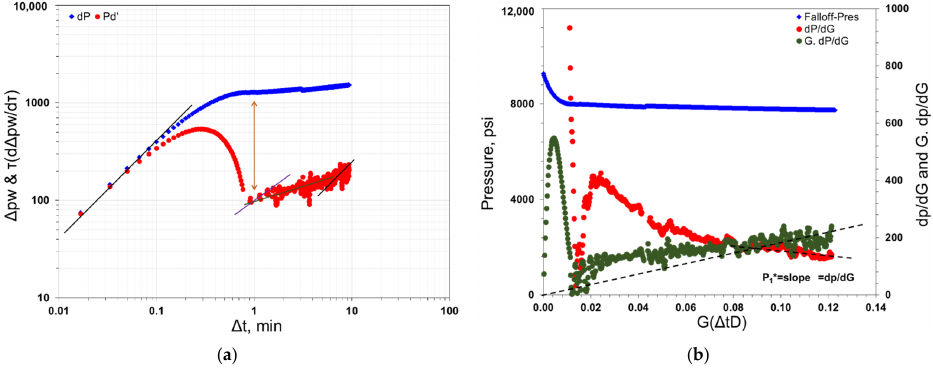
Figure 12. (a) Case #1, Bourdet pressure derivative plots for the main hydraulic fracture treatment for W2. (b) Case #1, G-function plots for the main hydraulic fracture treatment for W2.